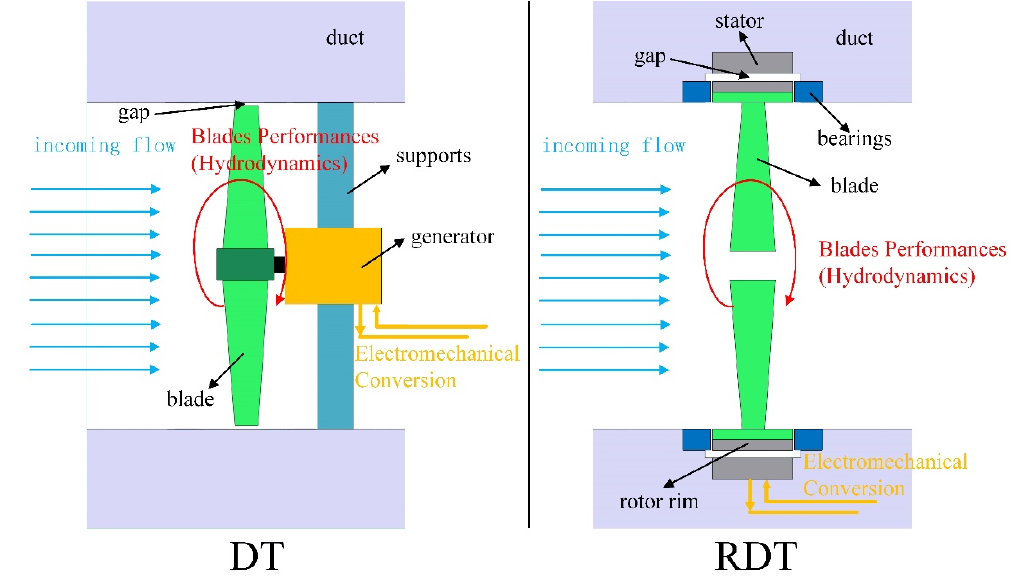
Figure 1. Principle comparison between a DT and a RDT.